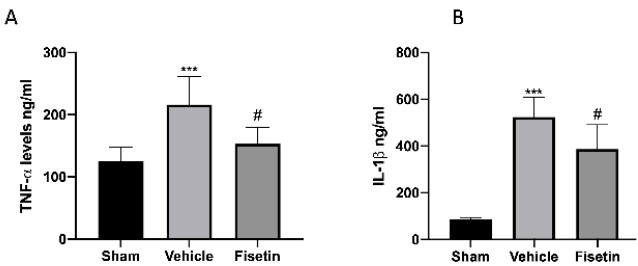
Figure 6. Fisetin administration on inflammatory cytokines in peritoneal fluids. TNF- α ( A ), IL-1 β ( B ). The results are means ± SEM of 6 animals for each group. *** p < 0.001 vs. sham, # p < 0.05 vs. vehicle.